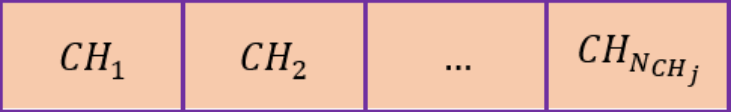
Figure 2. Solution Representation.